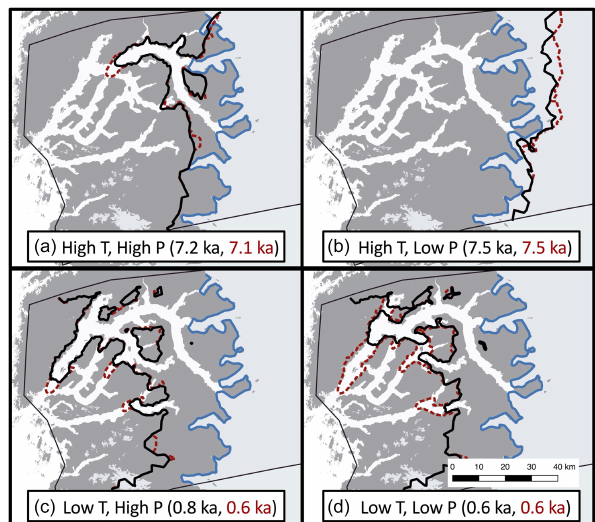
Figure 8. Age of minimum ice extent for each simulation (black text: simulations with calving; red text: simulations without calv- ing). The black line denotes the minimum ice extent for simulations with calving. The dashed red line denotes the minimum ice extent for simulations without calving. The present-day ice extent is shown as the blue